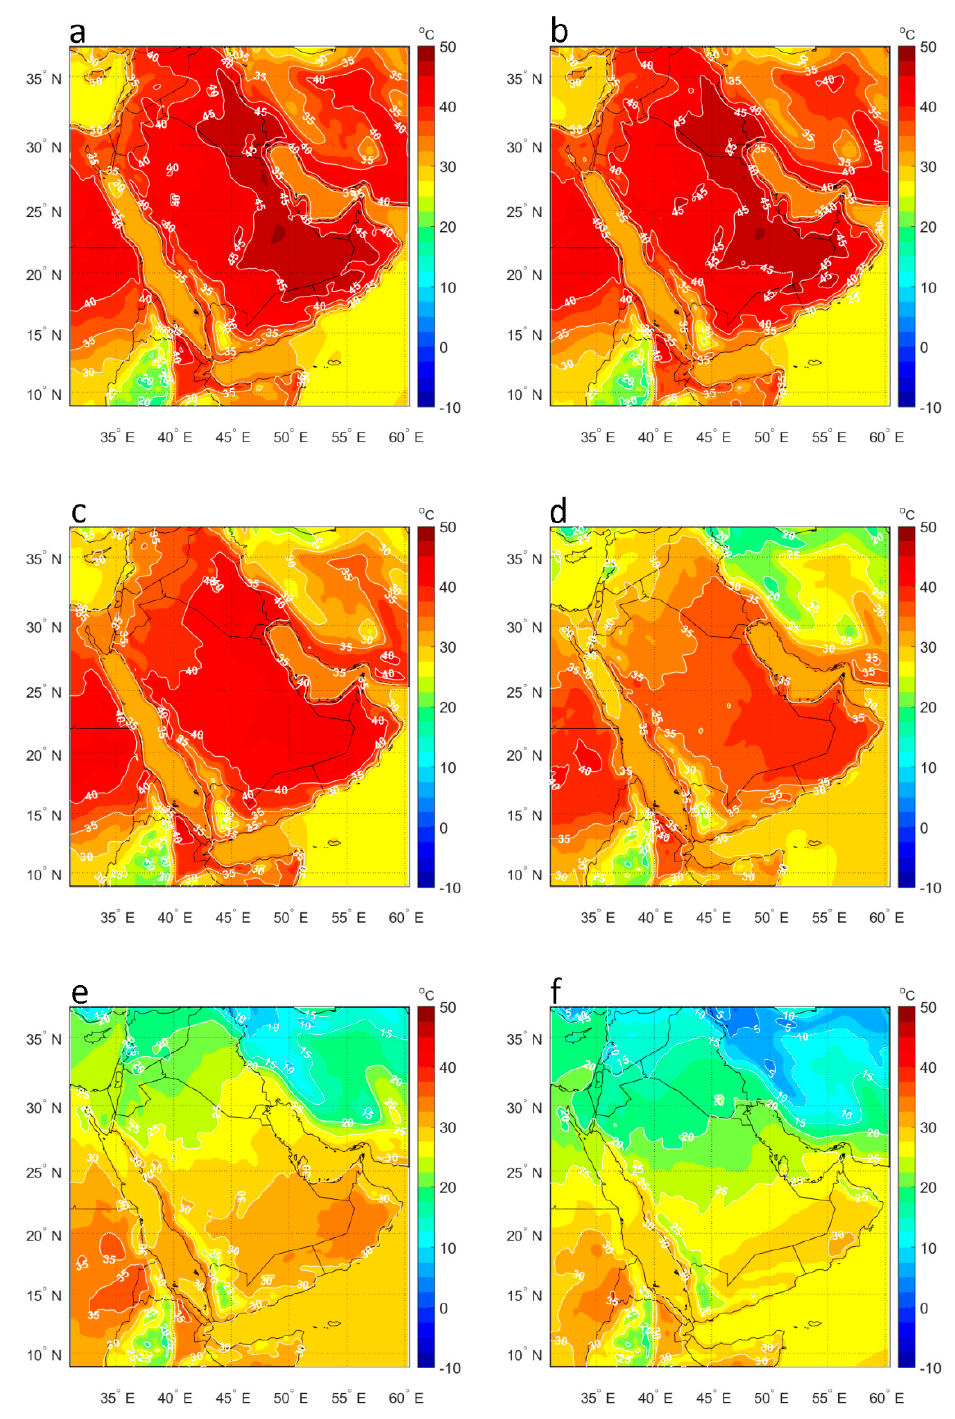
Figure A4. Mean values of daily maximum temperature for the months July to December ( a – f ).